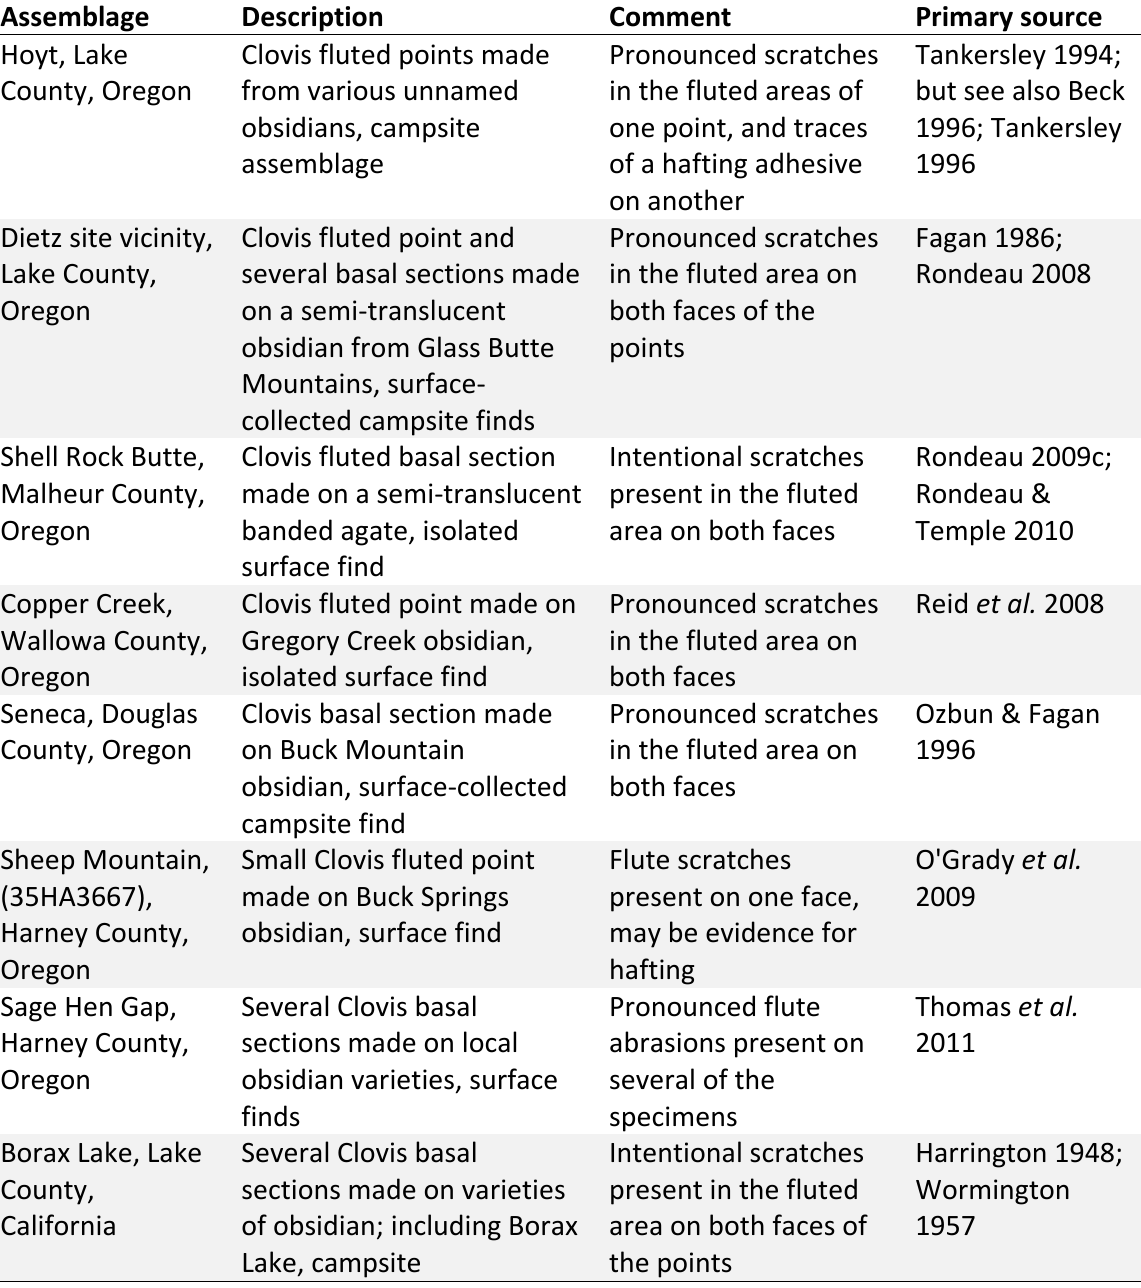
Table 2. Occurrences of Clovis points that display scratches and or abrasions that may indicate evidence to facilitate